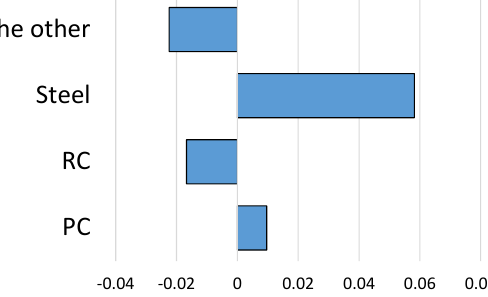
Figure 4. Superstructure material category scores (main girders).